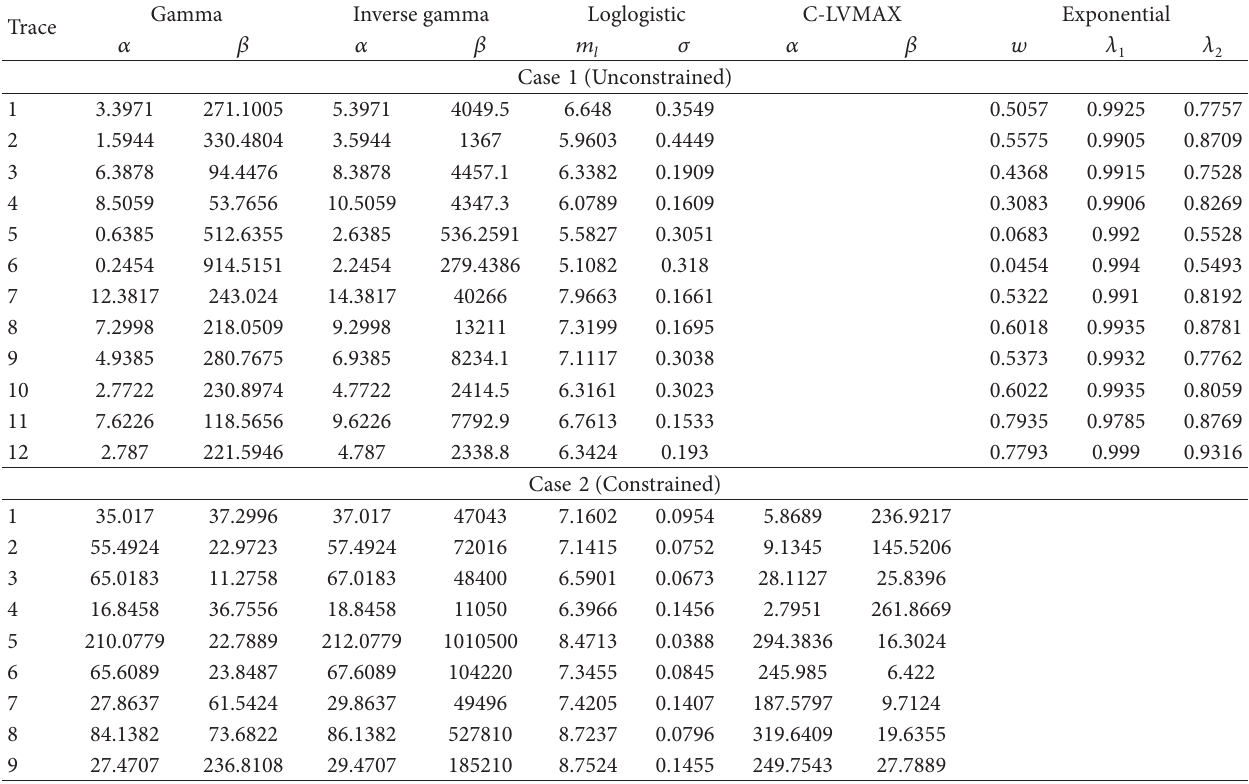
T 2: Parameter values of the modeling